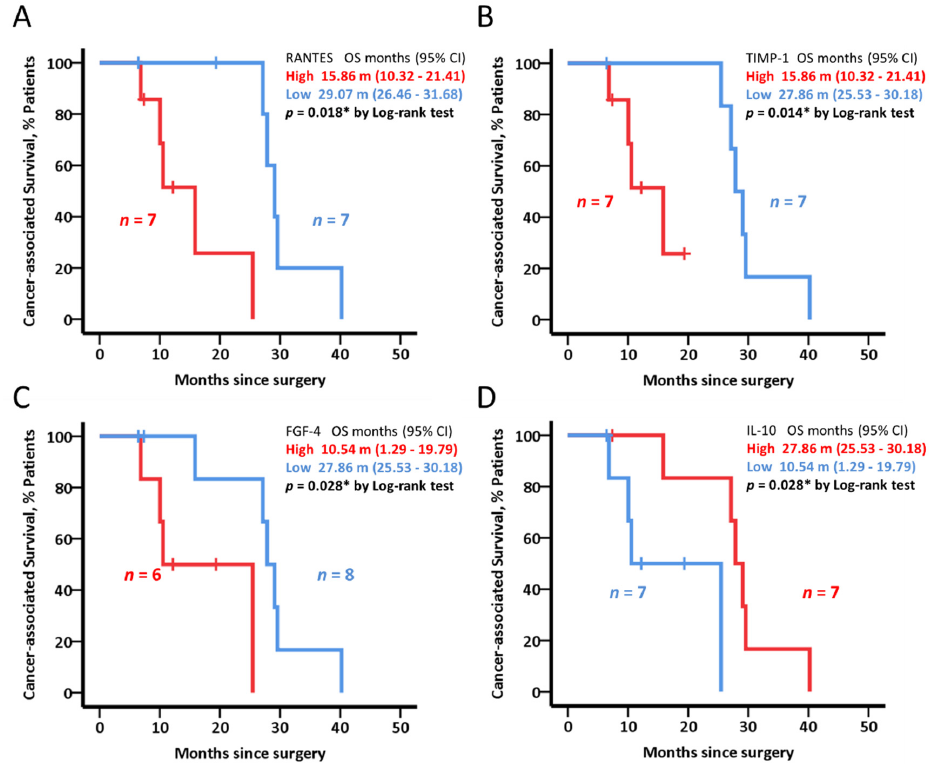
Figure 4. Cancer-associated survival analysis of baseline cytokine levels in resectable patients (n = 14). Kaplan–Meier plots represent cancer-associated death in resectable patients stratified by the median baseline levels of RANTES ( A ), TIMP-1 ( B ), FGF-4 ( C ) and IL-10 ( D ), lower than the median (blue) or higher than the median value (red). In the text, OS and 95% CI values are shown. Log-rank test was used to test for statistical significance. * in the figures indicate significant ( p < 0.05), statistical